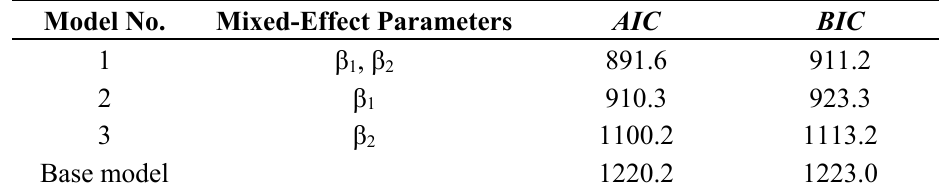
Table 3. Values of AIC and BIC of mixed-effect models and the base model for first-order branches.